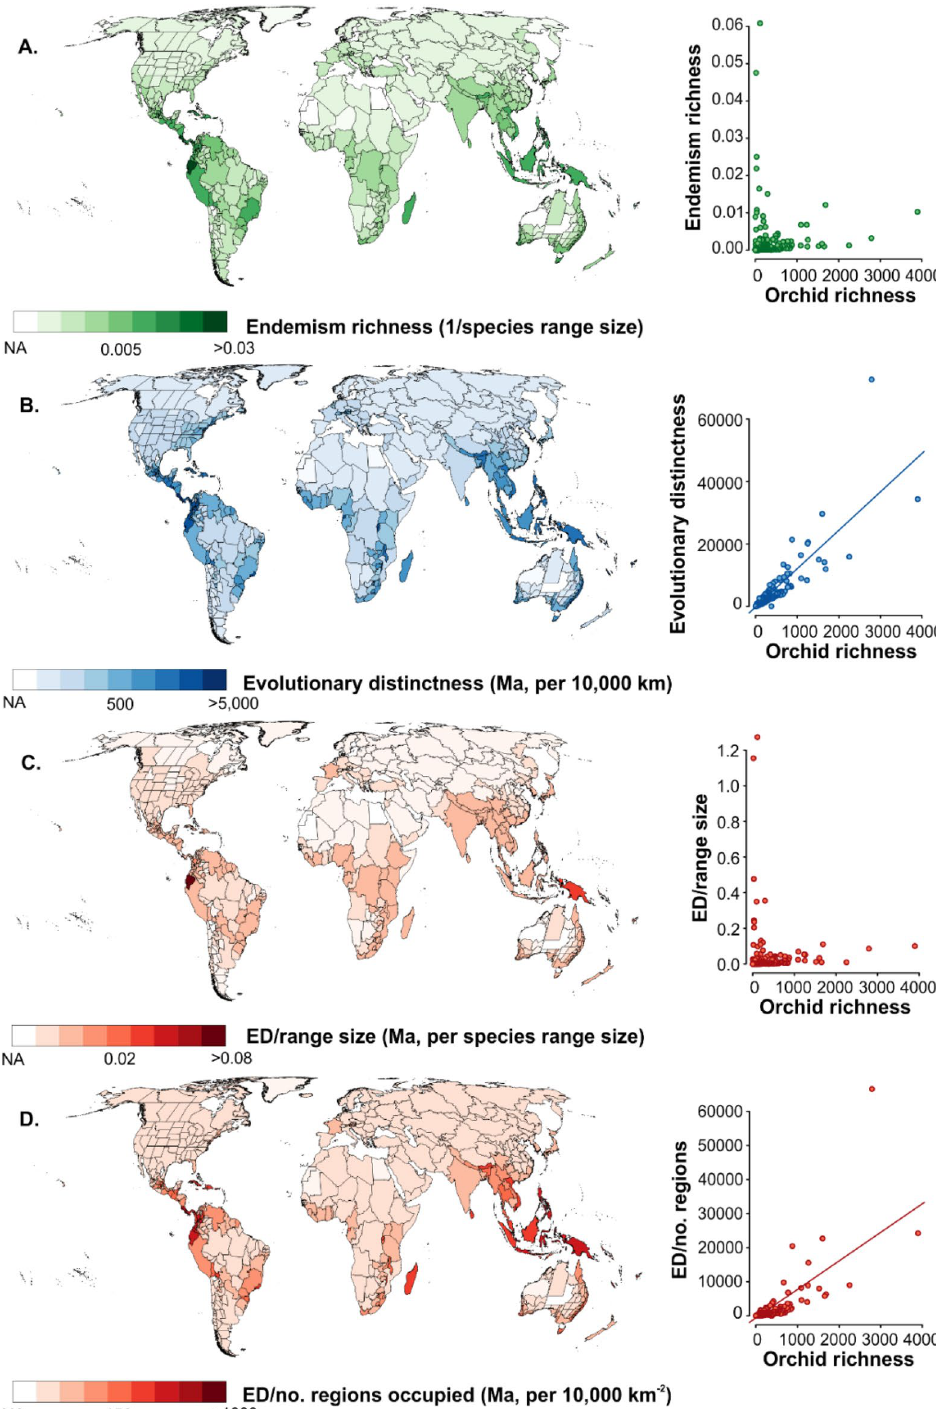
Figure 1. World maps highlighting centres of orchid ( A ) endemic species richness ( B ) evolutionary distinctness ( C ) evolutionary distinctness based on the range size of species ( D ) evolutionary distinctiveness based on the number of regions species occupy. All calculations, maps and other graphics were created using R 3.5.1, R Core Team. R software: Version 3.5.1. R Found. Stat. Comput. (2018) https:// doi. org/ 10. 1007/ 978-3- 540-